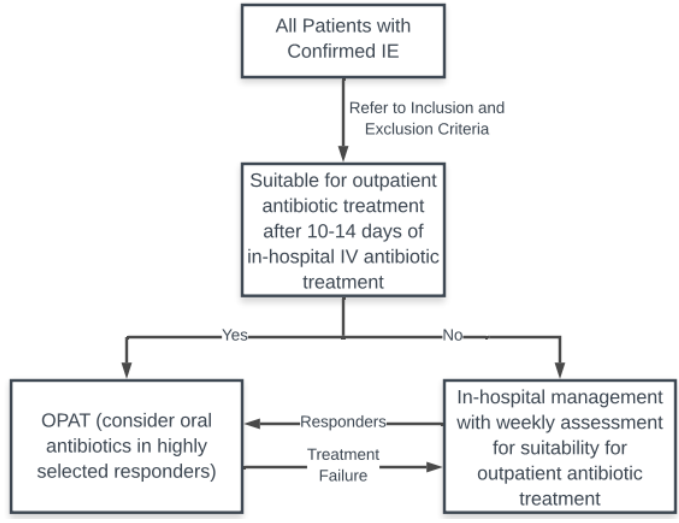
Figure 1. Suggested OPAT pathway. IE: infective endocarditis; IV: intravenous.